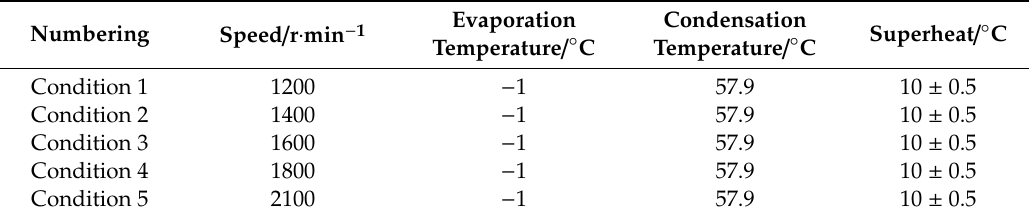
Table 2. Variable rotational speed experimental operation conditions.